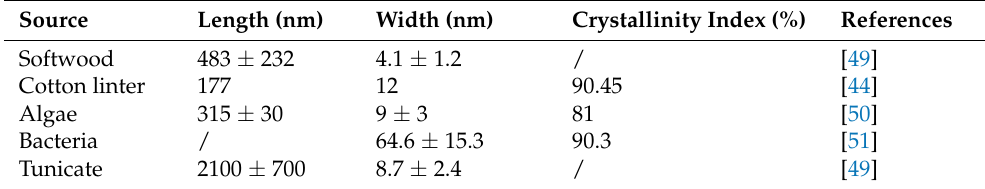
Table 1. Examples of the geometrical dimensions and crystallinity index of nanocellulose from various sources.